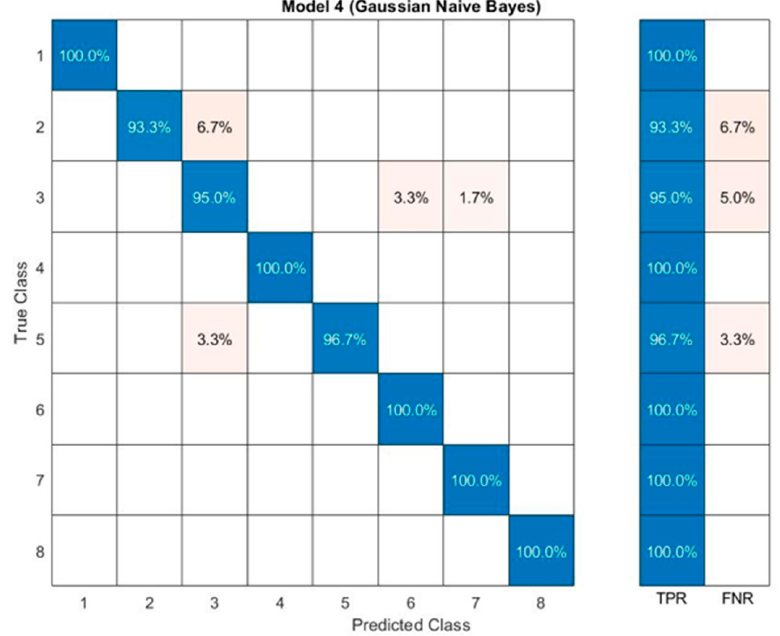
Figure 10. Gaussian-Naïve-Bayes-model confusion matrices.